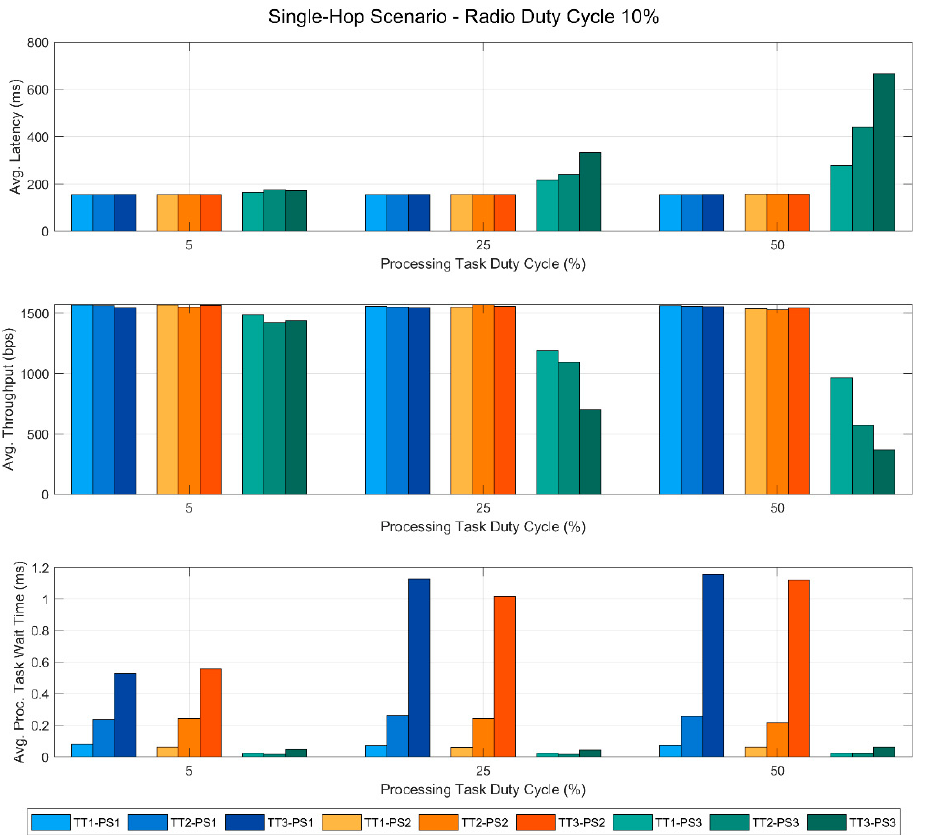
Figure 5. Single-hop scenario with a fixed RDC of 10%.